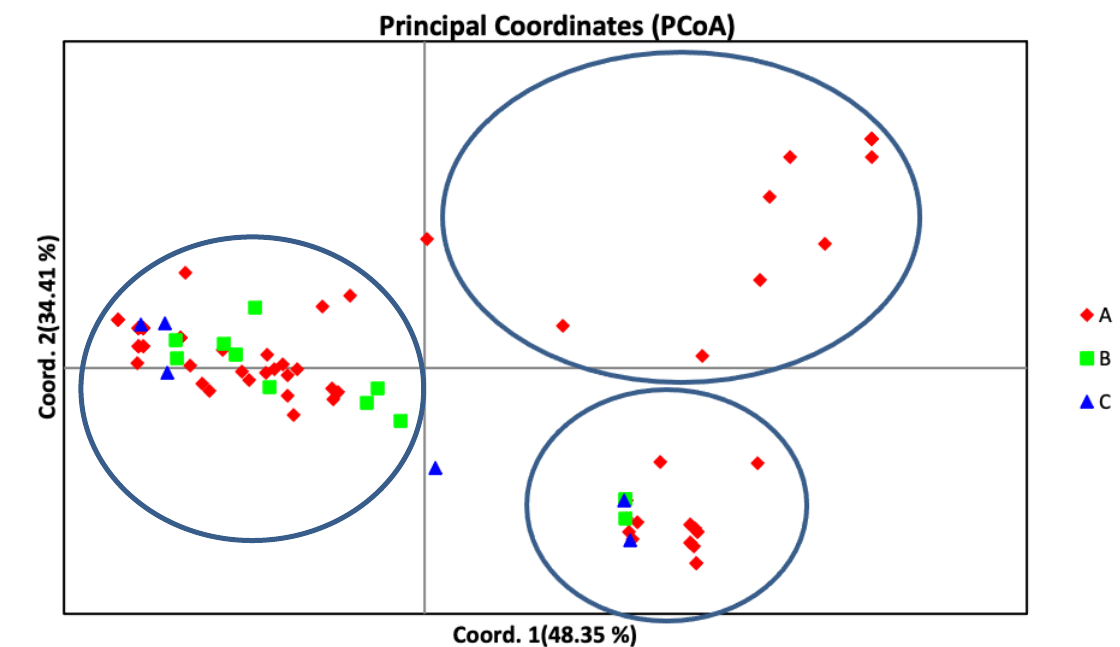
Figure 3. Principal-coordinate analysis showing the diversity of D. rabiei isolates clustered in the three subpopulations collected from three regions (A = Pop-A; B = Pop-B; C = Pop-C). The circles represent the grouping of the isolates.